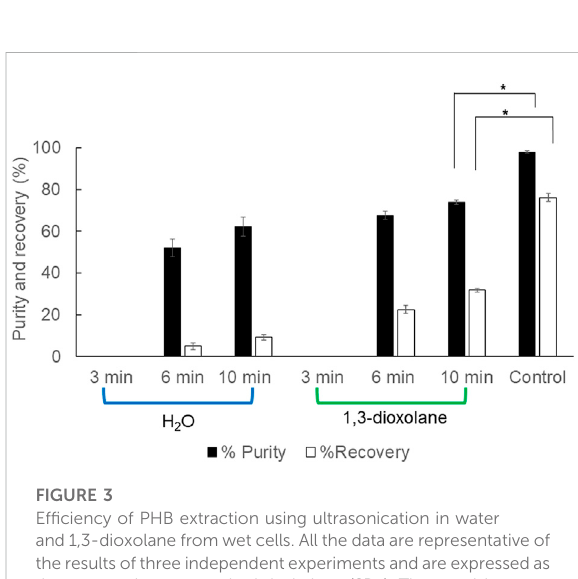
FIGURE 3 Ef fi ciency of PHB extraction using ultrasonication in water and 1,3-dioxolane from wet cells. All the data are representative of theresults ofthreeindependentexperiments andareexpressedas the mean values ± standard deviations (SDs). The asterisk indicates a signi fi cant difference ( p <